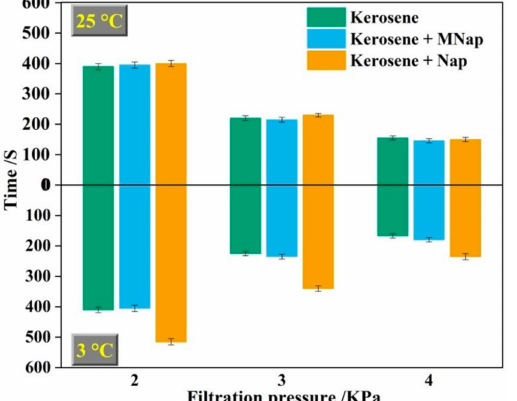
Figure 10. Filtration time of flotation concentrate with three collectors at different pressures and tem-